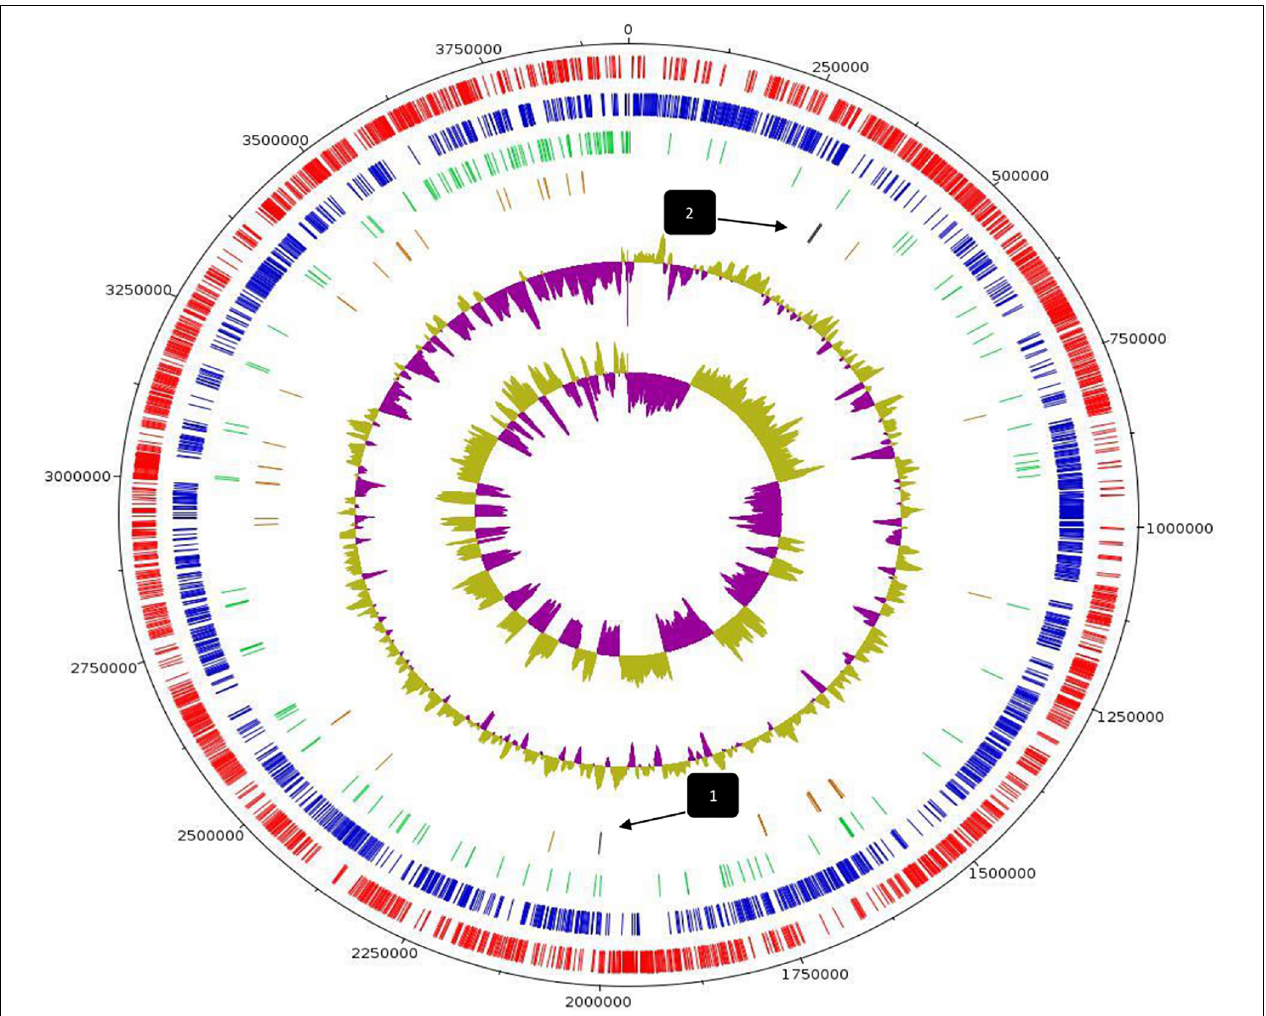
FIGURE 1 | Circular genome map of L. pentosus L33. From outer circle to inner, information is displayed as follows: Genome Size (black), Forward strand CDS (red), Reverse strand CDS (blue), Pseudogenes (green), tRNA genes (brown), GC Content, GC Skew. Arrows indicate the position of CRISPR